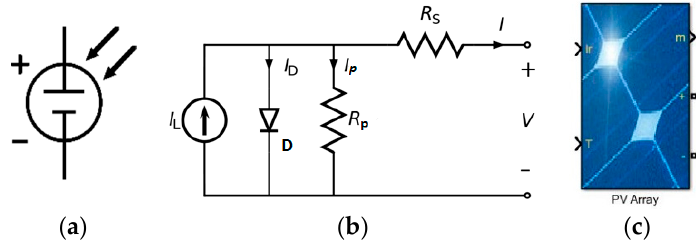
Figure 3. Modelling of Solar cell ( a ) Symbol; ( b ) Equivalent circuit of Solar Cell; ( c ) Solar Panel.